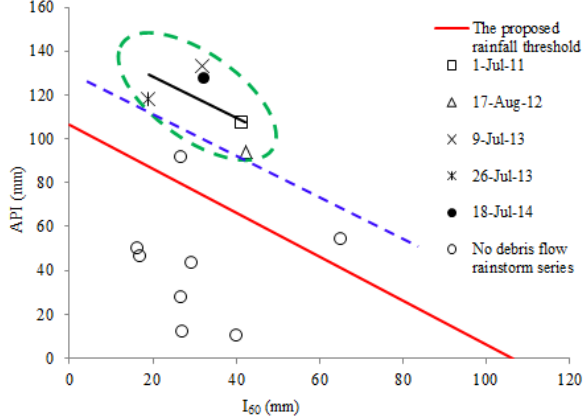
Figure 14. The calculated rainfall threshold curve (red line), the trend line (black line) of the debris flow events and the debris flows triggering thresholds (dashed line) in Guojuanyan